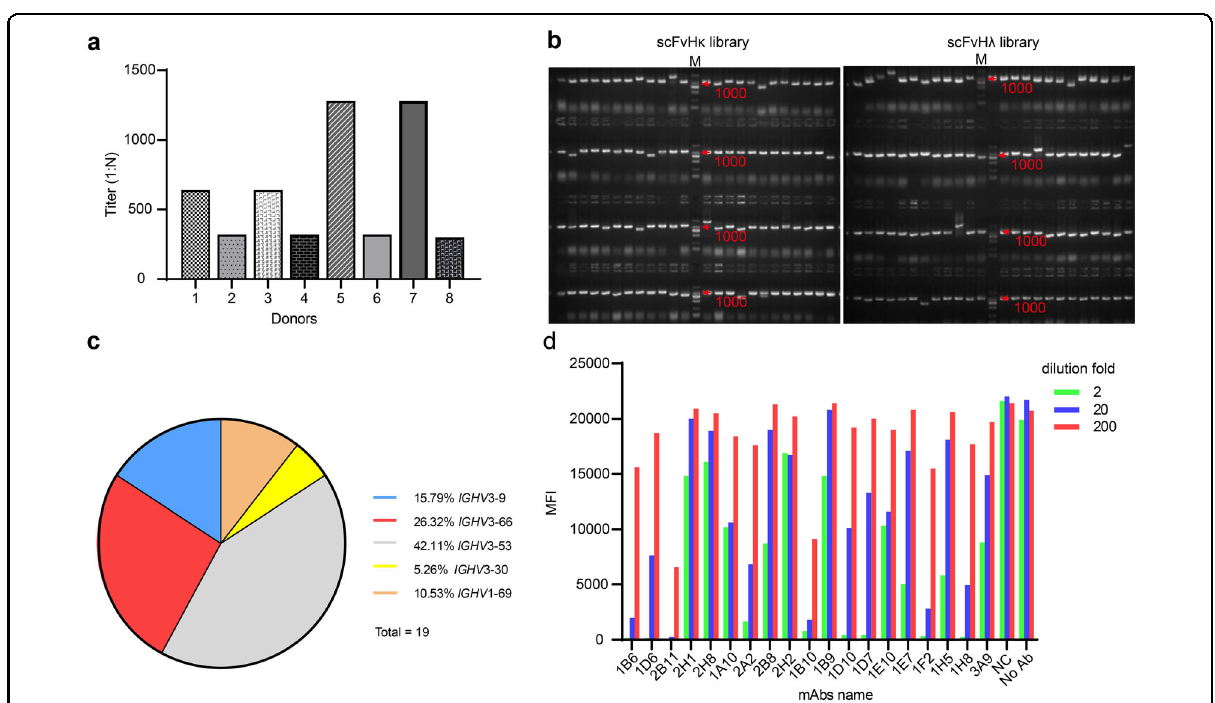
Fig. 1 Isolation of SARS-CoV-2 S1 or RBD-binding antibodies. a The RBD-speci fi c antibody titers in the plasma of different convalescent patients. The titers were represented as 1:N, and N is the highest dilution factor of a serum sample that causes a positive test reaction. b The insertion rate of scFvH κ and scFvH λ libraries by colony-PCR. Ninety-six colonies were randomly picked for PCR, and the target fragment is about 1 kb. The DL 2000 maker was used to de fi ne the molecular weight. c IGHV gene usage assessment. The distribution of gene usage is shown for a total of 19 unique clones. d Competition fl ow cytometry assay using ACE2-expressing cells. Phage clones ’ supernatants were diluted 2-, 20-, and 200-fold before testing.